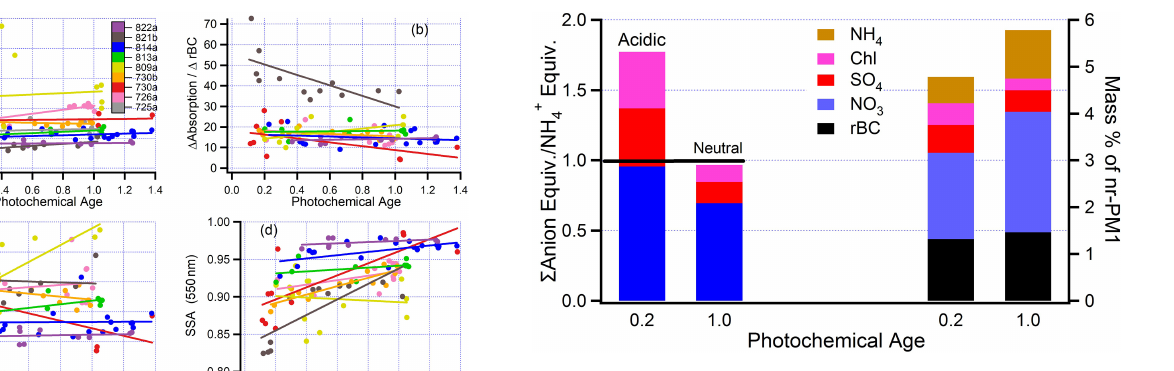
Figure 12. Inorganic composition of fresh and aged BB aerosol (photochemical age = 0.2 and 1.0, respectively) averaged over nine flights. On the left equivalence ratios of cations relative to NH + the right mass ratios relative to nr-PM1. The difference between the stacked bars on the right and 100% is organic